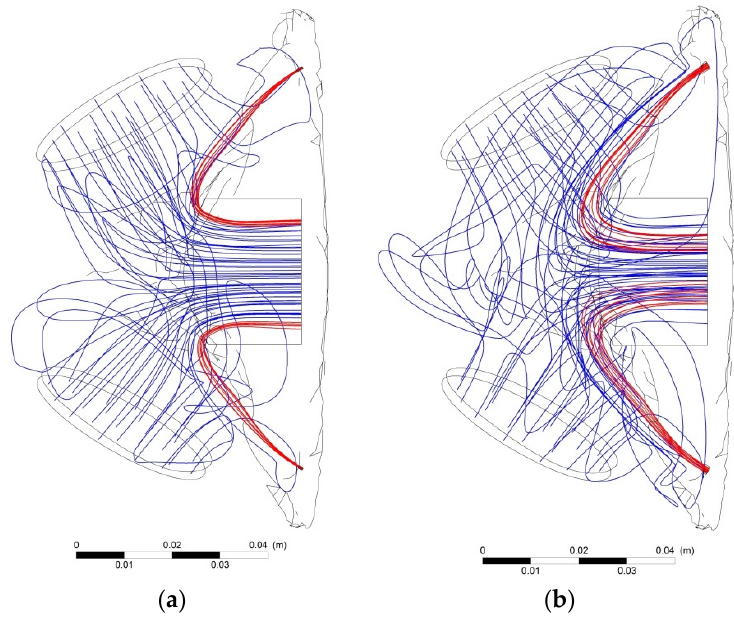
Figure 4. ( a ) Velocity contours for the leak with the cross-sectional area of 0.5 mm 2 and ( b ) 5 mm 2 . Figure 5 shows the flow lines of the inhaled air. The blue lines are the flow lines of the air passing through filters, and the red lines are the flow lines of the air inhaled through the facepiece leaks.